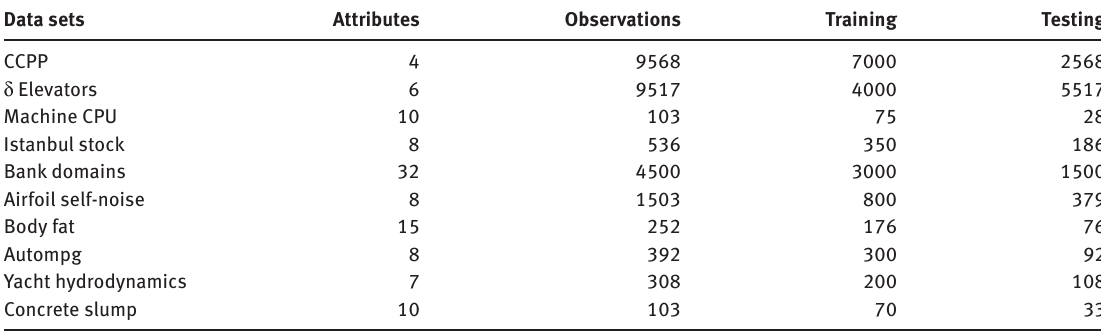
Table 1: Specification of Benchmark